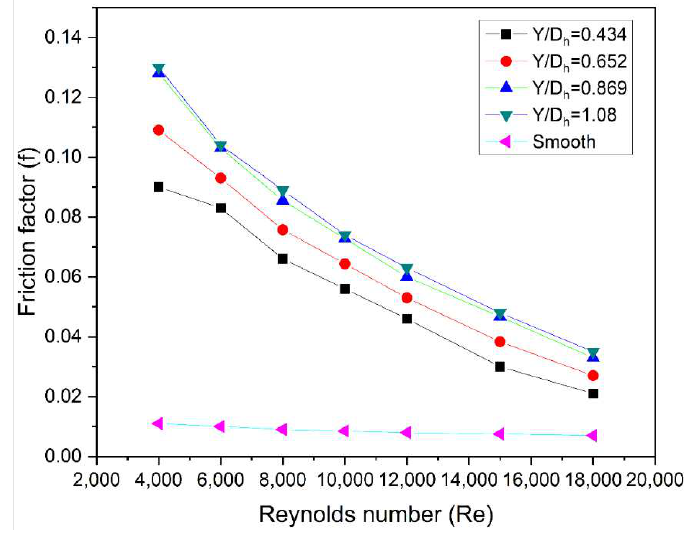
Figure 11. (cid:16) variation with (cid:8)(cid:9) as a function of (cid:25)/(cid:22)